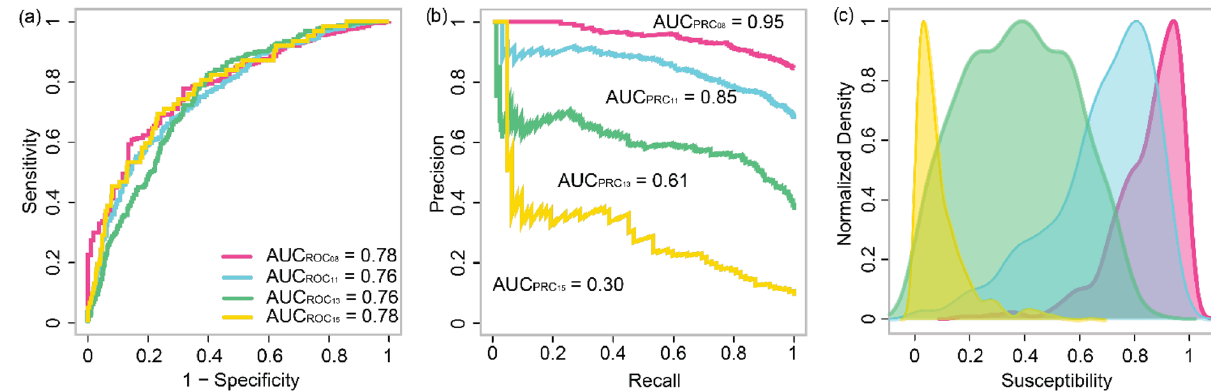
Figure 2. Model performance and susceptibility distribution. ( a ) ROC curves, ( b ) PR curves, and ( c ) probability density functions of landslide susceptibility for the coseismic (2008) and three postseismic (2011, 2013, 2015) scenes of the WEER-MLI [software: R 3.6.3, https:// cloud.r- proje ct.